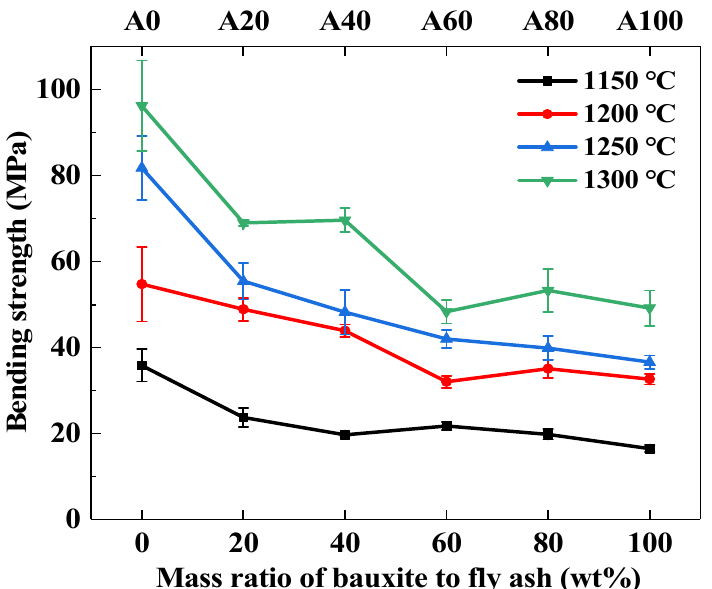
Figure 8. Three-point bending strength of fly ash supports obtained by sintering at different temperatures with different bauxite contents.